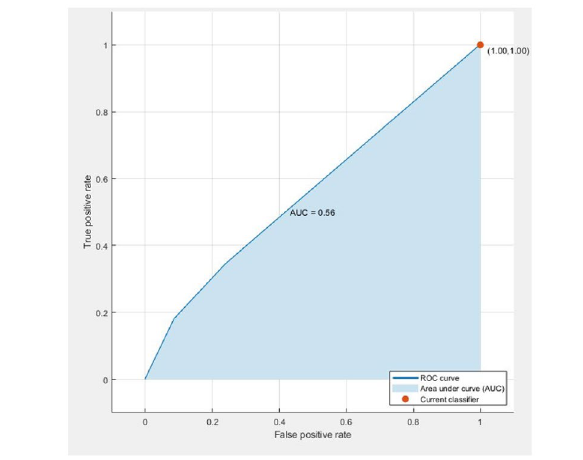
Figure 5. ROC curve for the prediction of PDL1 expression using radiomic phenotypes: radiomic phenotypes were used to predict PDL1 expression using a Random Forest classifier and obtained a fivefold cross-validated AUC of 0.56.